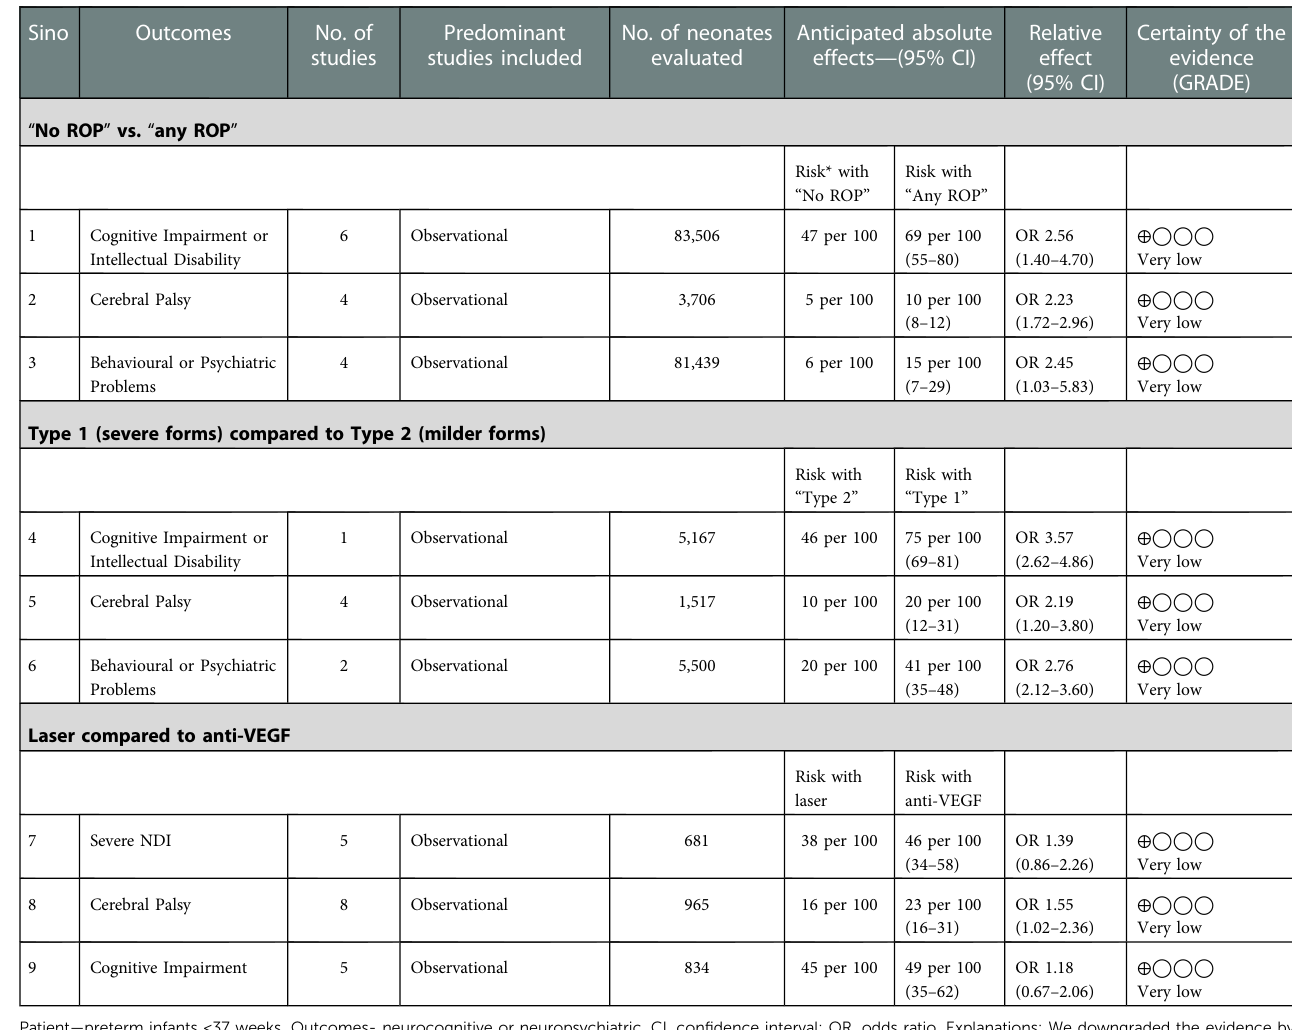
TABLE 2 GRADE summary of fi ndings